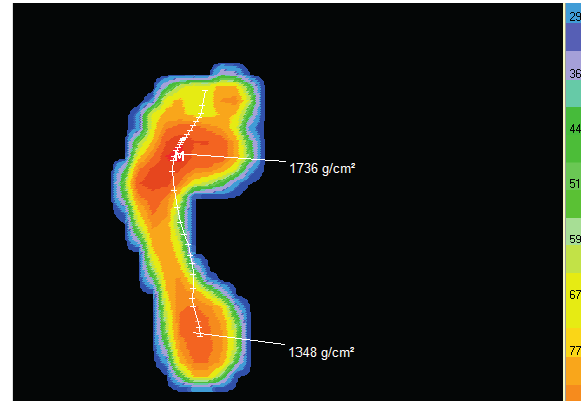
Figure 2 - Results of dynamically measured of peak plantar pressure left foot barefoot.